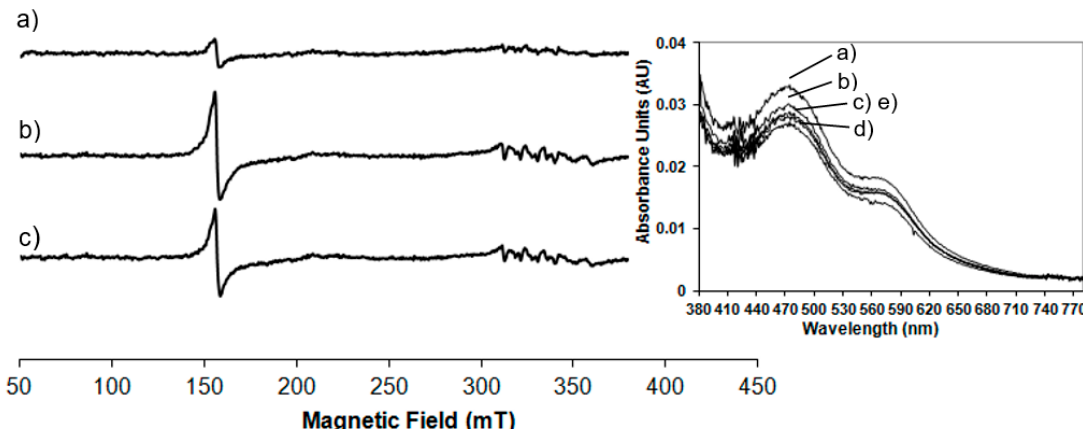
Figure 4. Low temperature (20K) EPR spectra of NDO samples, collected after 10s before freezing in liquid nitrogen: ( a ) mixed with an equal volume of O 2 -saturated naphthalene before and ( b ) after treatment with H 2 O 2 . ( c ) 20K EPR spectrum of NDO, in the absence of naphthalene, treated with H 2 O 2 . All spectra were recorded at 9.38GHz; 1mT modulation amplitude; 2mW microwave power and 100KHz modulation frequency. In the inset: room temperature UV-Vis spectra of ( a ) native NDO; ( b ) NDO after the addition of H 2 O 2 , t0 min; ( c ) t1 min; ( d ) t5 min; and ( e ) t10 min.